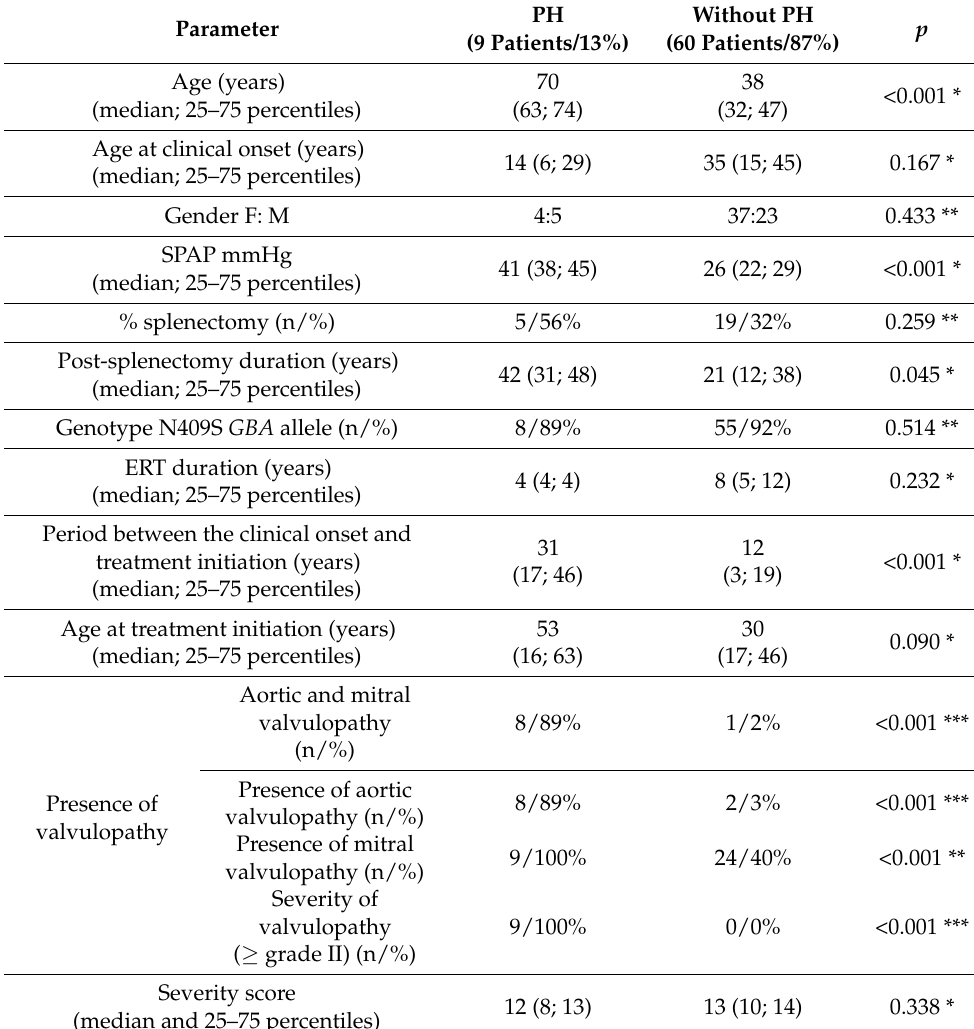
Table 3. Characteristics of GD patients with PH compared to those without